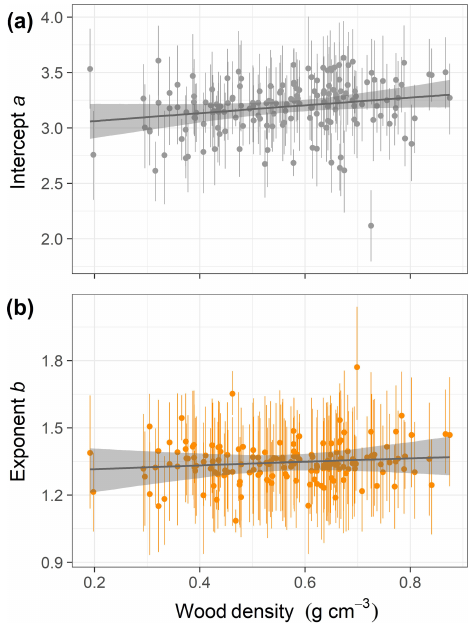
Figure 3. Relationships of species-specific crown area allome- try parameters with wood density in the second-best hierarchical model, which incorporated a power function (the best model in- cluded no covariates; Table 1). Points show median posterior esti- mates for each individual species, with vertical bars indicating 90% posterior central intervals. The thick grey line depicts the fitted re- lationship across species, while the shaded envelope encloses the 90% posterior